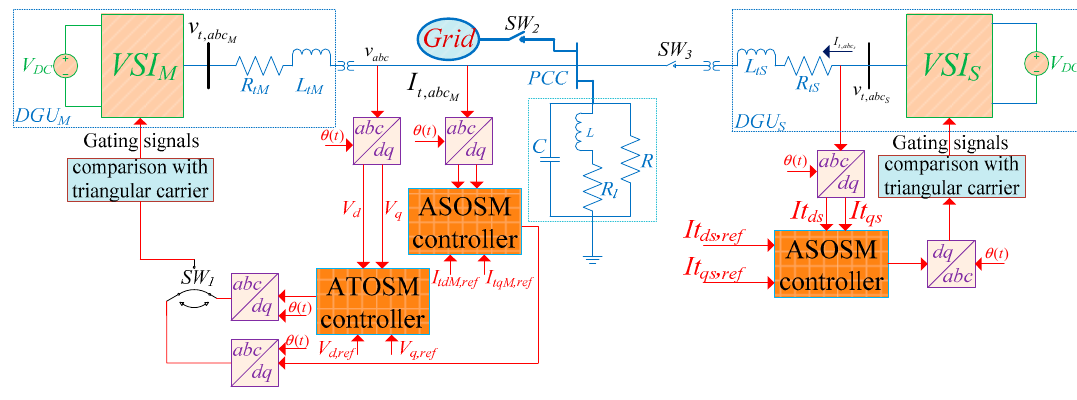
Figure 1. Single-line diagram of a master-slave microgrid.